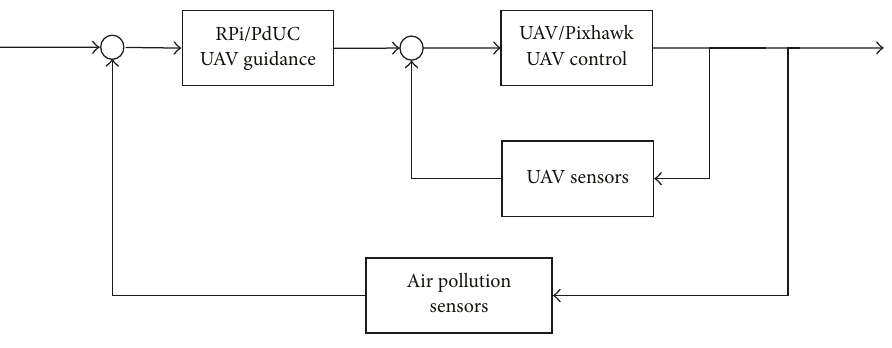
Figure 2: UAV control